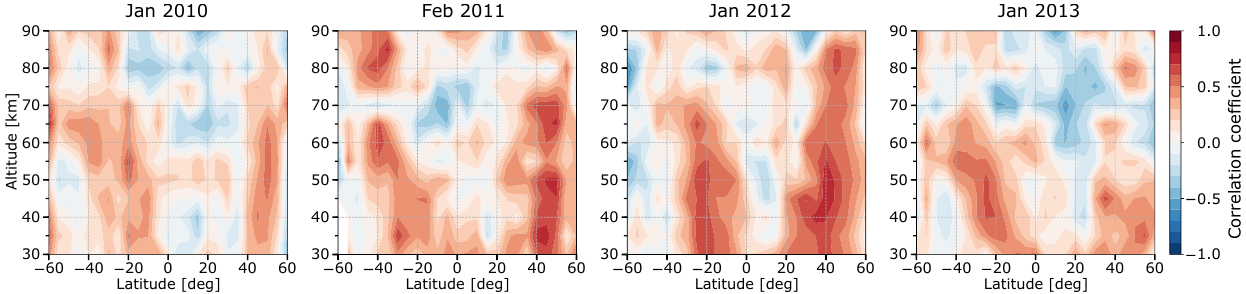
Figure 5. Same as Fig. 3 but for austral summer.